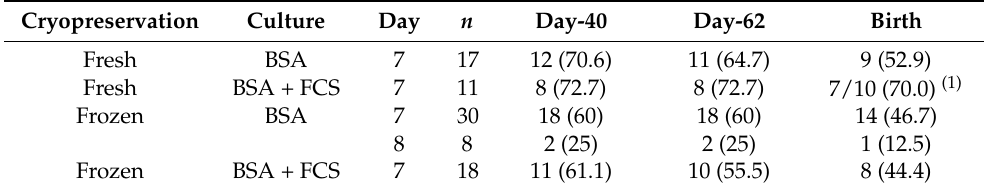
Table 1. Descriptive pregnancy rates (%) at gestational endpoints Day-40, Day-62 and birth of frozen and fresh in vitro produced embryos arranged by culture conditions from Day-0 to Day-6. Cryopreservation Culture Day